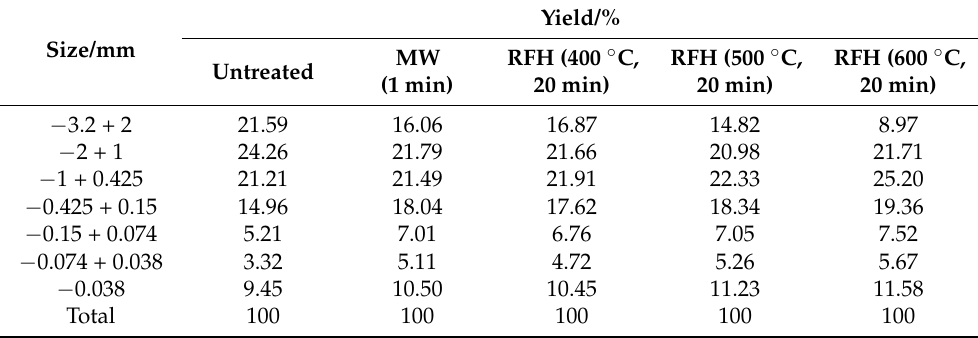
Table 5. Effect of temperature in the traditional heating with water cooling on the particle size distribution of the grinding product.